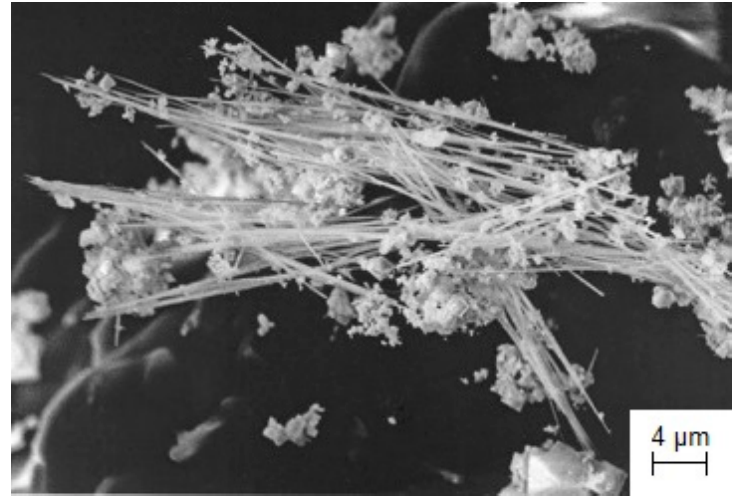
Figure 20. SEM image of TaO obtained by electrolysis of the CsCl-K 3 TaOF 6 (2.5 wt.%) melt at 1023 K and a current density of 0.15 A cm − 2 . Table 1. Summary of electrochemical synthesis of functional coatings and nanomaterials in molten salts. Molten Salt